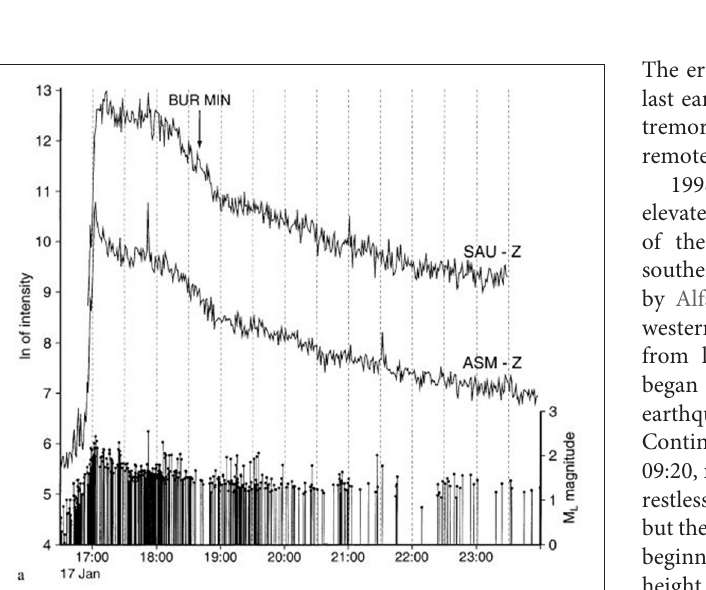
FIGURE 5 | Seismogram of May 5, 1970 from the vertical, short-period seismograph at the WWSNN-station at Akureyri, 200km N orth of Hekla, showing the seismic activity associated with the beginning of the eruption of the volcano. From Einarsson and Björnsson (1976). Reproduced with the permission of the copyright holder, Jökull.